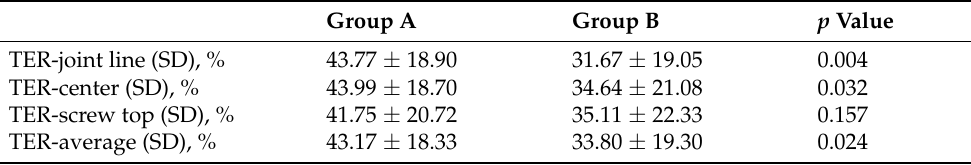
Table 3. Tunnel Enlargement Rate of three cutting levels and their average value on sagittal MRI imaging one year post